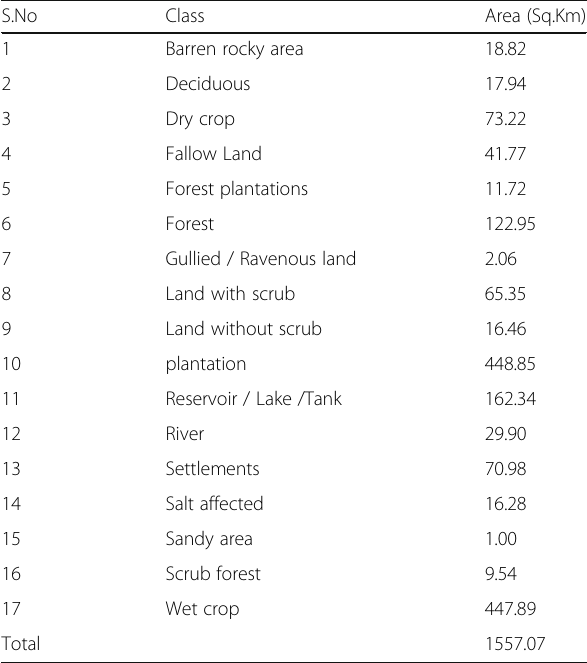
Table 3 Land use classification of the study area